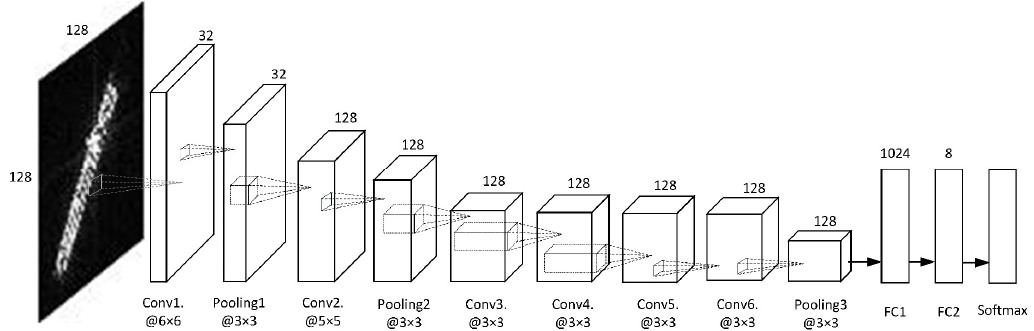
Figure 2. The structure of the proposed classification model.